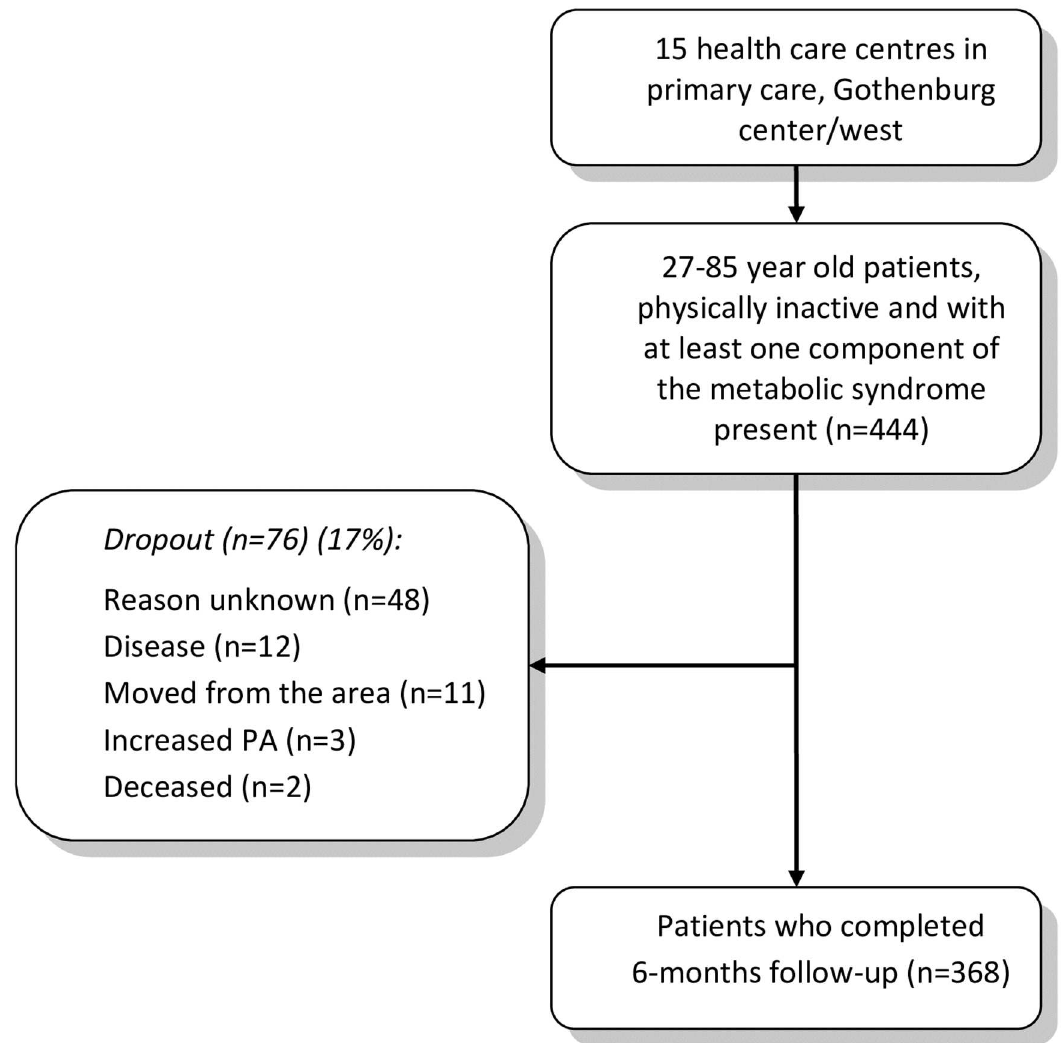
Fig 1. Flow of patients involved in the study. The patients were recruited from 15 healthcare